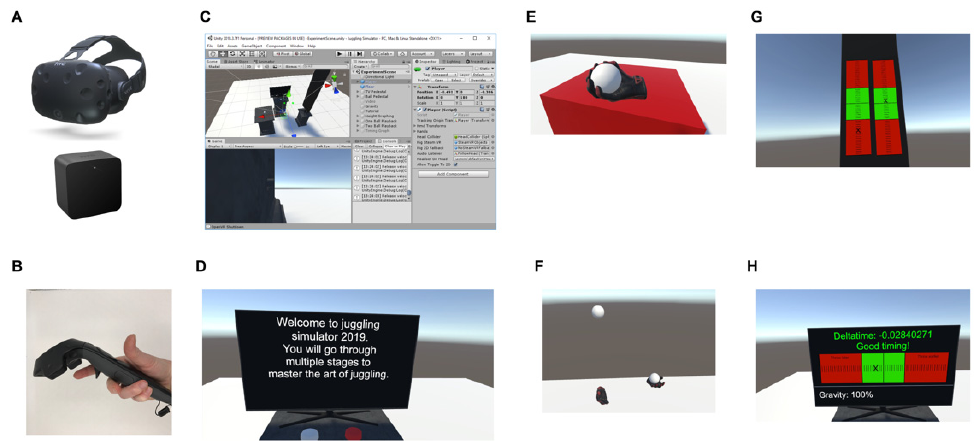
Figure 1. Hardware and user interface. The HTC Vive headset and the base station is shown in ( A ); the HTC hand controller is shown in ( B ). In ( C ), the interface of Unity, which was used to create the juggling simulation, is shown. ( D ) shows the TV within the VR environment that subjects received instructions on. ( E ) shows the hand and the ball used in the juggling simulator. ( F ) shows a picture of the two-ball juggling tutorial that subjects were shown in VR and asked to imitate. The height and timing feedback given to subjects in the feedback group is shown in ( G , H ), respectively.